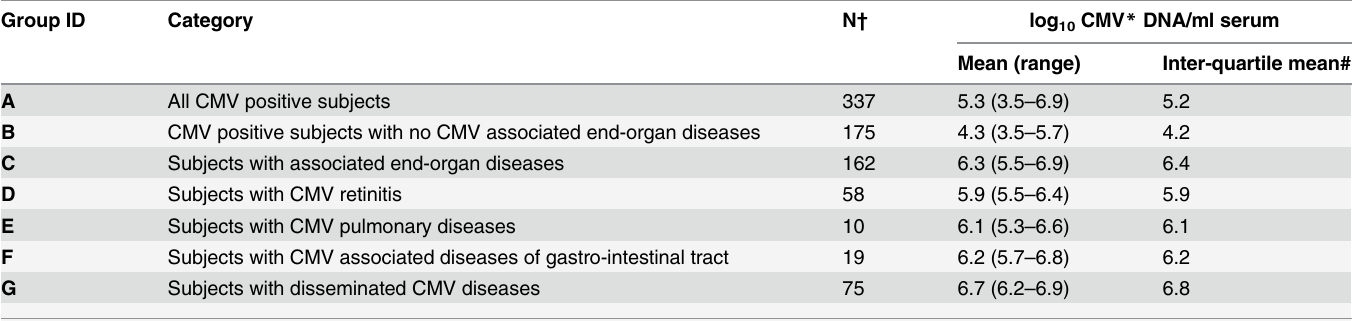
viral load for the development of EOD and EODs (disseminated CMV EOD). The CMV viral load cut-off value (expressed in log10 CMV viral load) for the development of CMV EOD was obtained as 5.4 (P < 0.0001) and that for the development of disseminated CMV EODs was ob- tained as 6.4 (P < 0.0001). The obtained values were associated with a high sensitivity (97.5%; 95% CI-93.80% to 99.32% and 90.7; 95% CI — 81.7% to 96.2% respectively) and specificity (96.0%; 95% CI- 91.9% to 98.4% and 97.0% 95 CI%- 94.1% to 98.7%) along with high positive predictive val- ues (95.8%; CI- 91.5% to 98.3% and 89.5%; 95% CI 80.31% to 95.34%) and high negative pre- dictive values (97.7%; 95% CI- 94.2% to 99.4% and 97.3%; 95% CI- 94.6% to 98.9%) respectively (Fig. 3 and Table 4).